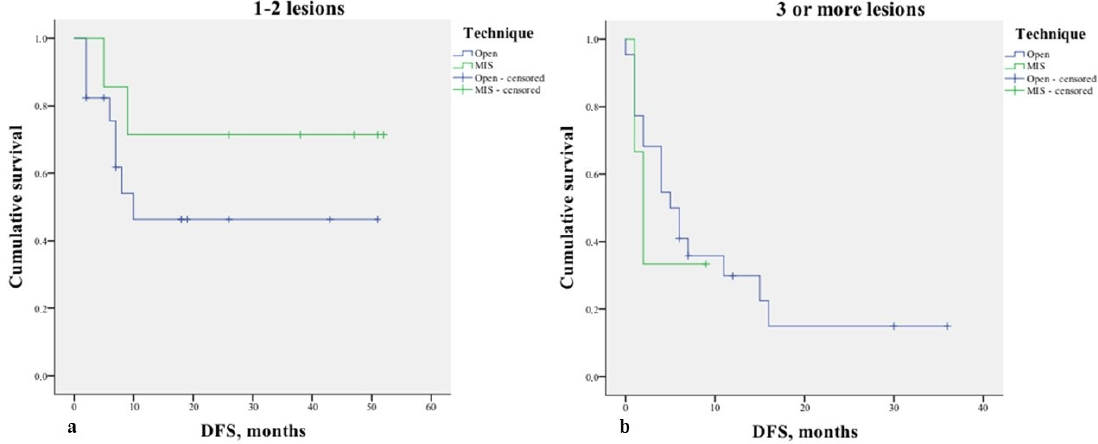
Figure 5. Kaplan–Meier curve of disease-free survival (DFS) ( p = 0.527) stratified by the preoperative number of resected lesions: ( a ). 1–2 lesions. Mean DFS rates for open surgery and MIS were 26.7 months ± 6 and 39.1 months ± 7.7, respectively; ( b ). 3 or more lesions. Mean DFS rates for open surgery and MIS were 10.4 months ± 2.7 and 4 months ± 2, respectively.